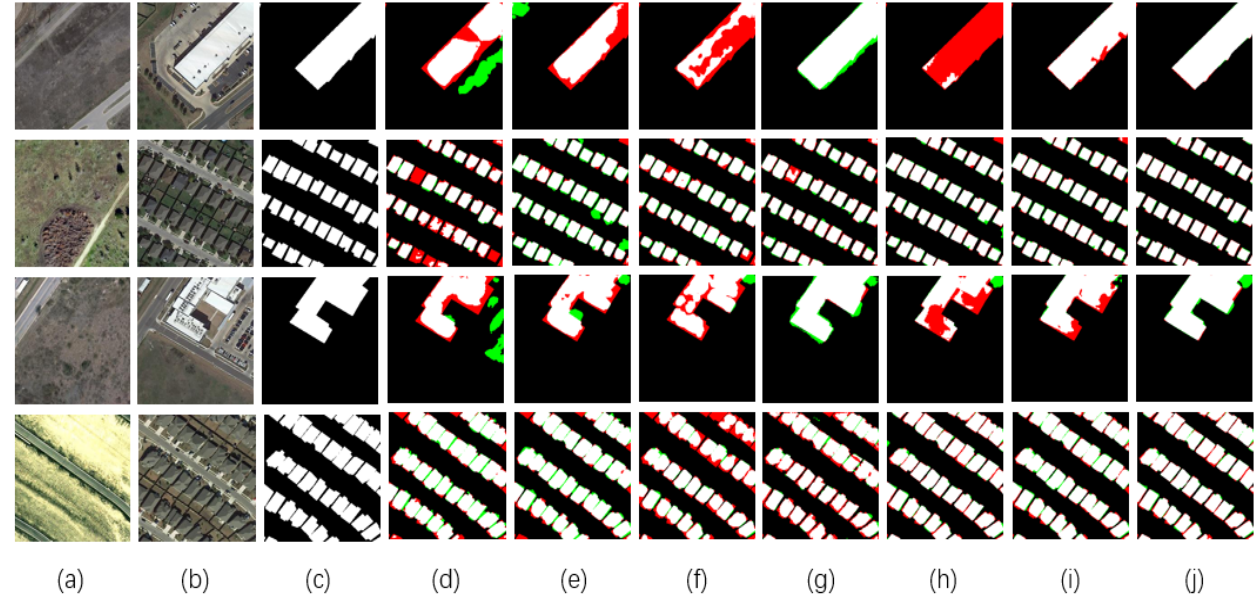
Figure 7. Visualization results of different methods for LEVIR-CD datasets. ( a ) T1 images. ( b ) T2 images. ( c ) Ground truth. ( d ) FC-Conc. ( e ) FC-Diff. ( f ) IFN. ( g ) DDCNN. ( h ) SNUNet. ( i ) BIT. ( j ) Ours. In the figure, white, black, red, and green represent TP, TN, FN, and FP, respectively.